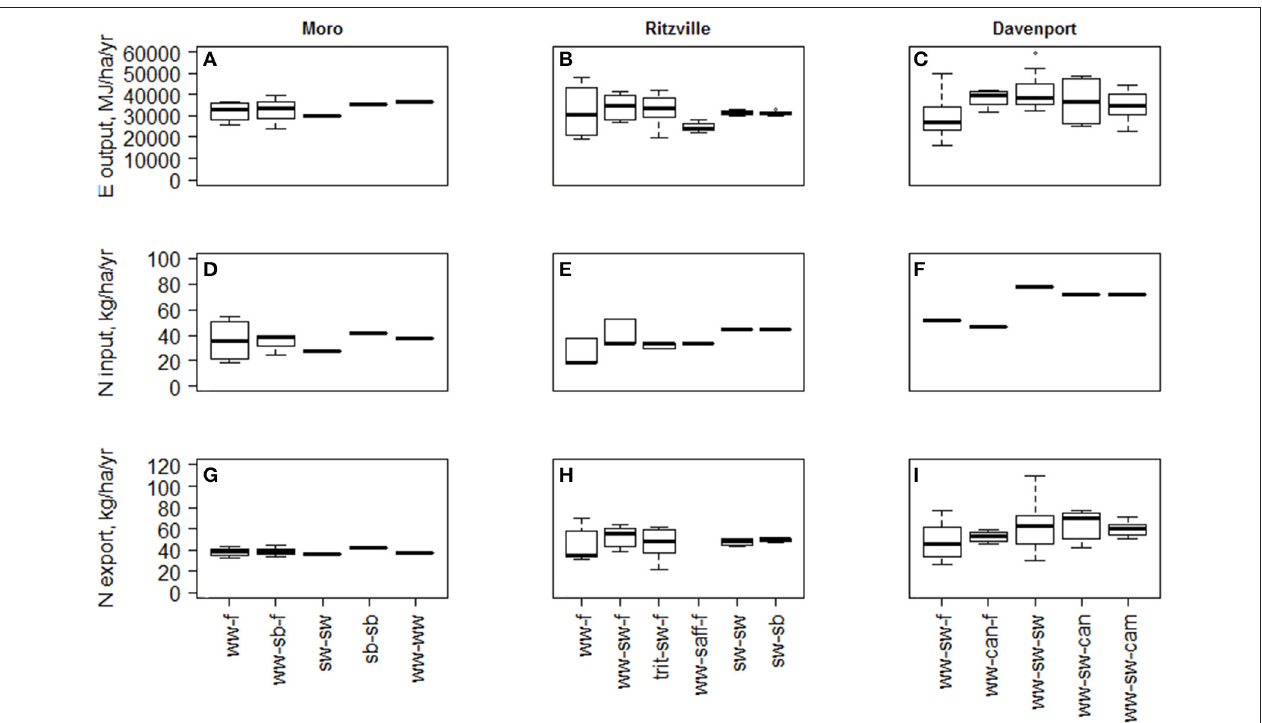
FIGURE 7 | Rotational fertilizer N inputs, energy outputs, and total grain N removal at Moro (A,D,G), Ritzville (B,E,H) , and Davenport (C,F,I) , respectively, in intensified and diversified conservation cropping systems research. Rotations are more intensified moving left to right of each graph. Inputs and outputs were summed over 3 years of observations, and annualized by dividing sums by years of observation. f, fallow; ww, winter wheat; sw, spring wheat; can, spring canola; cam, spring camelina; trit, winter triticale; saff, spring